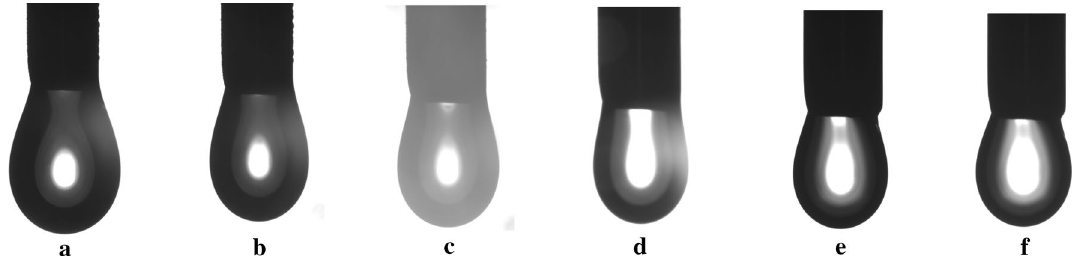
Fig. 2 Pendant drop of TEG in CO 2 environment at 50 °C and different pressures ( a at 20 bars, b at 50 bars, c at 70 bars, d at 100 bars, e at 150 bars and f at 200 bars). The liquid drop shape shrinks as the pressure increases from 20 to 200